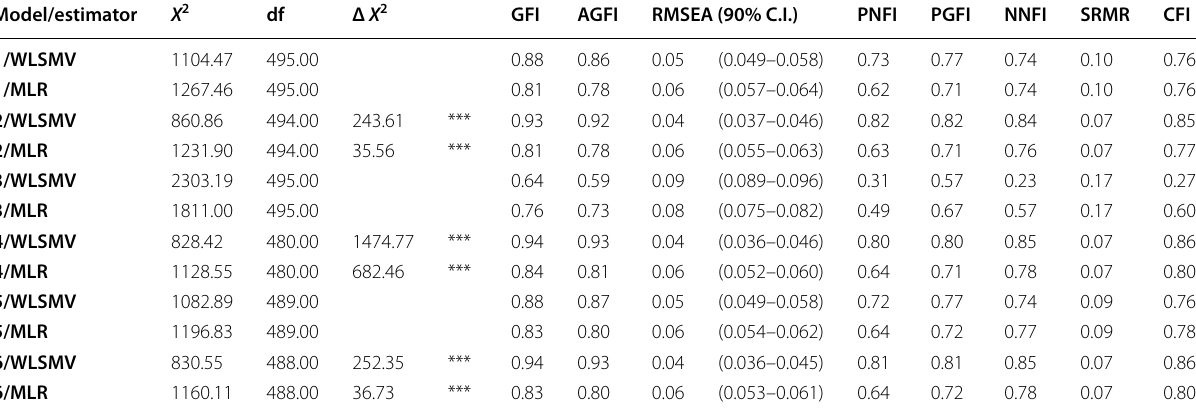
Table 2 Comparison of fit indices among the proposed models and different estimators (WLSMV/MLR)